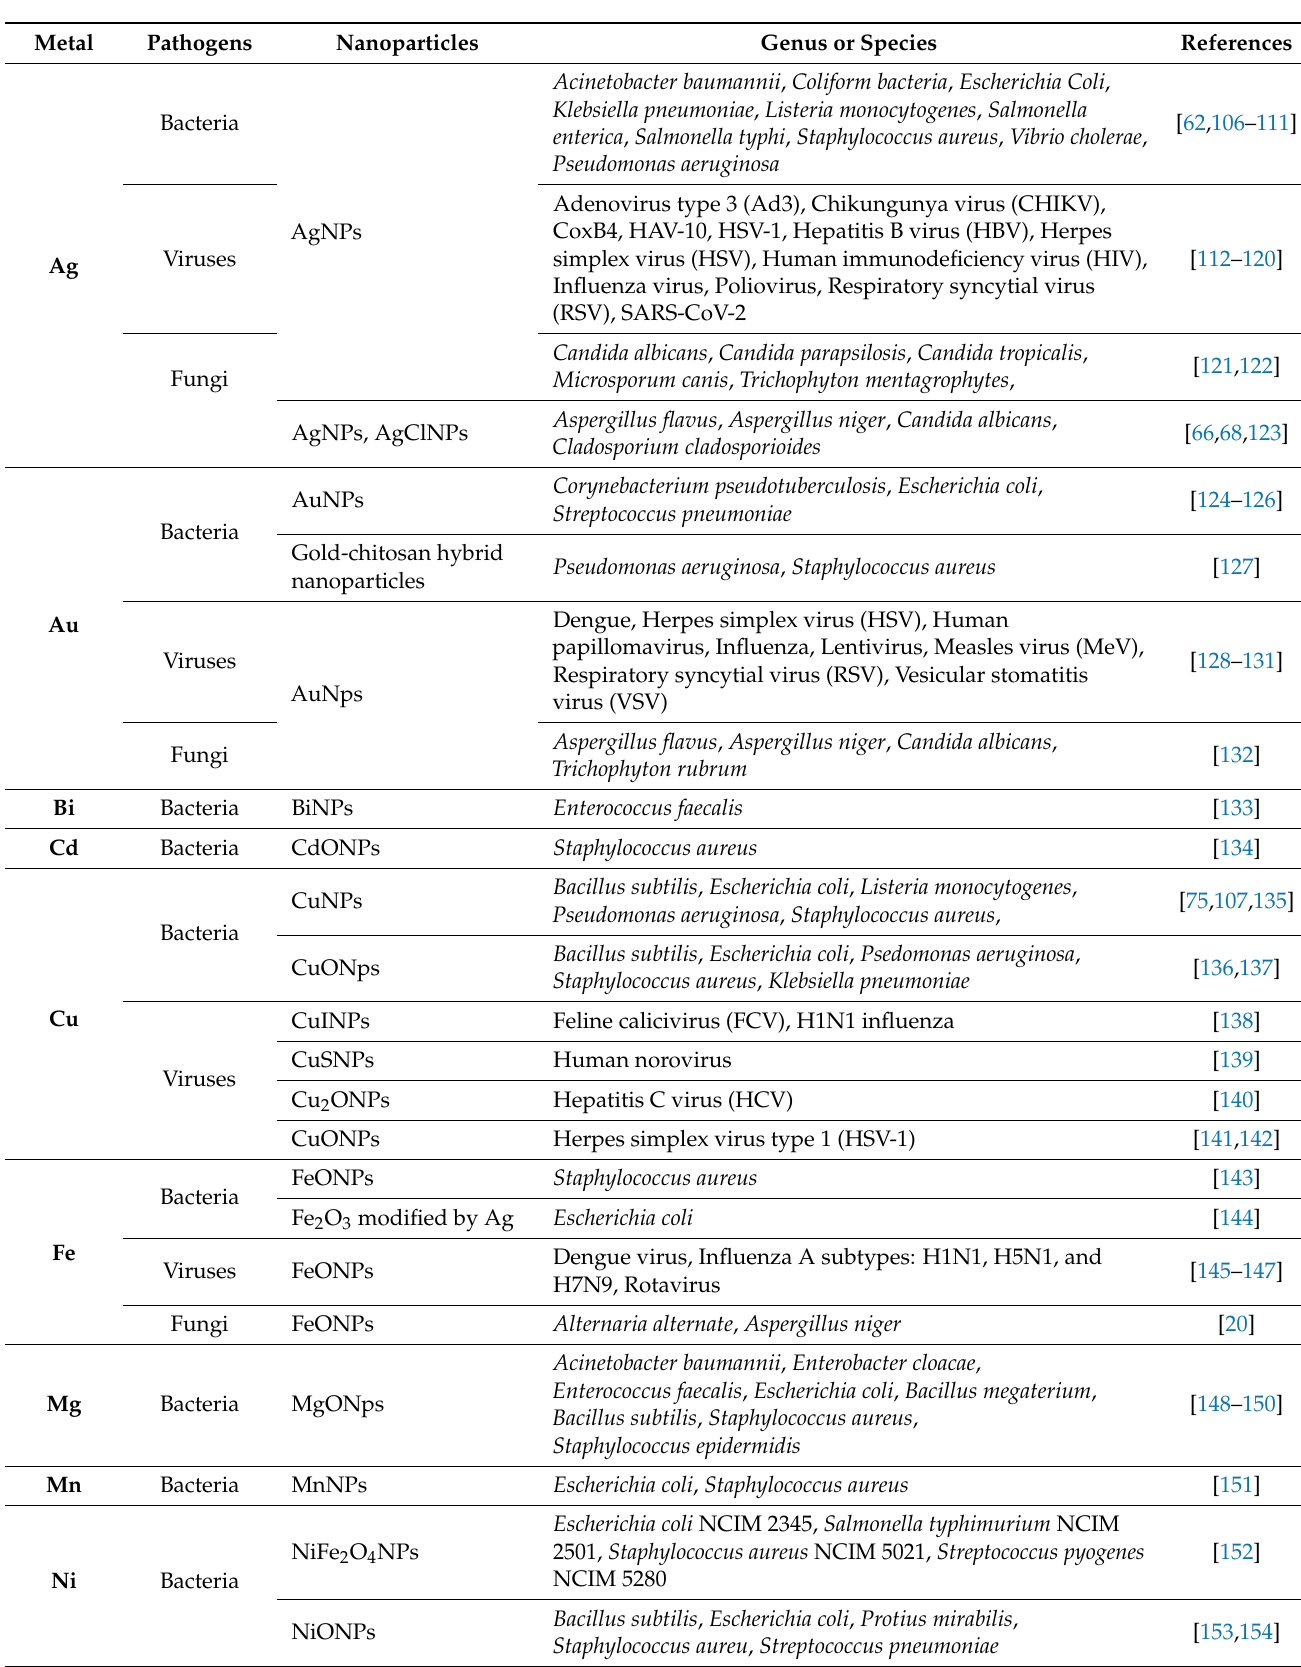
Table 2. Antimicrobial activity of metal